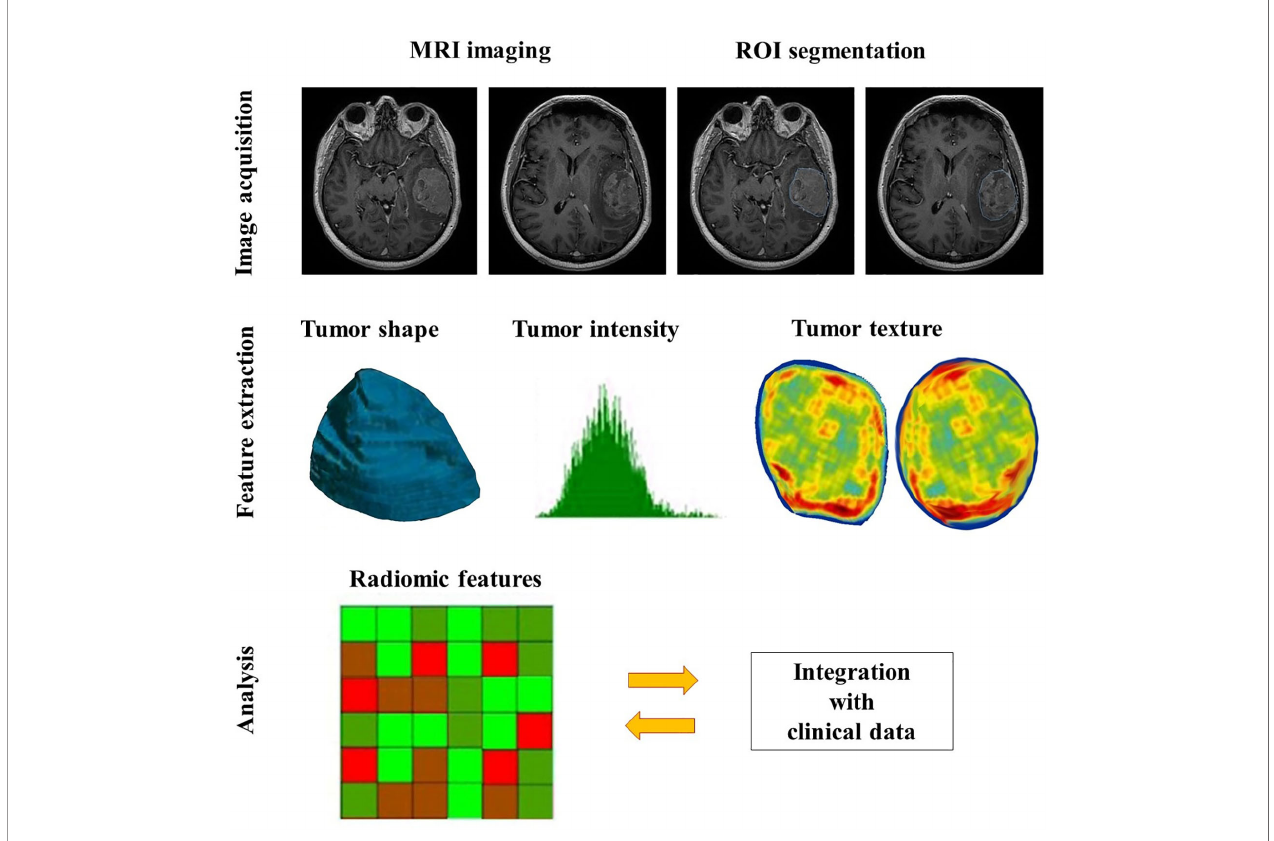
FIGURE 1 | The general work fl ow of radiomics in meningiomas includes image acquisition, ROI segmentation, feature extraction and